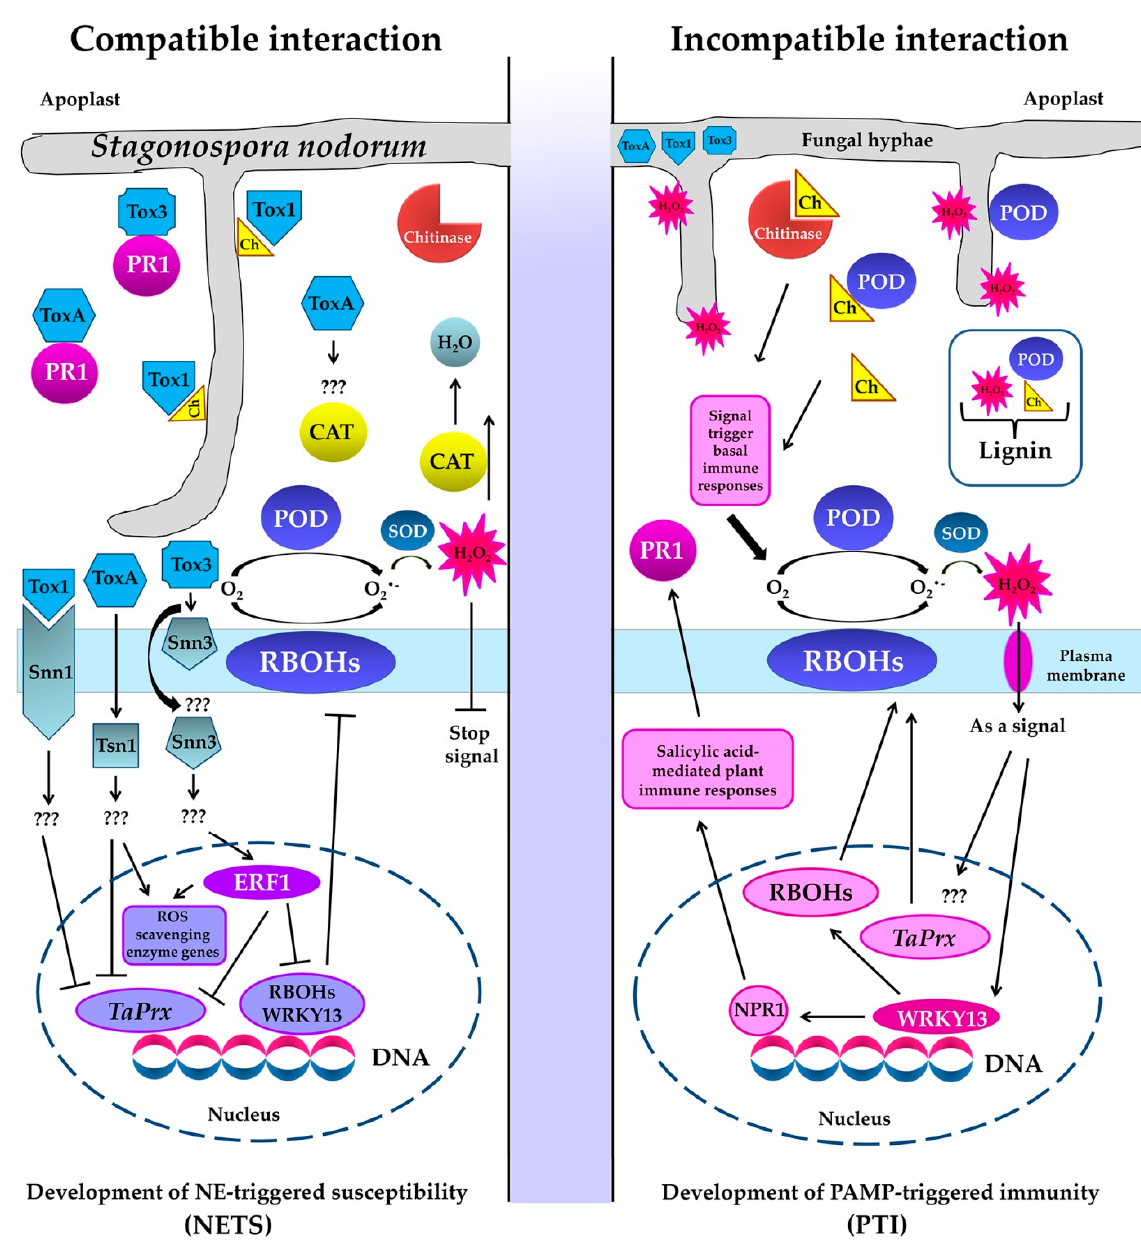
Figure 6. Model illustrating the development of necrotrophic effector-triggered susceptibility (NETS) in a compatible in- teraction and PAMP-triggered immunity (PTI) in an incompatible interaction with the participation of NEs SnToxA, SnTox1 and SnTox3 and enzymes of redox metabolism of the host plant (NADPH-oxidases localized on the plasmallema also known as respiratory burst oxidase homologs (RBOHs), peroxidases (POD) superoxide dismutase (SOD) and catalase (CAT)) in the S. nodorum – T. aestivum pathosystem. Legend: Ch—chitin, ERF1—transcription factor Ethylene responsive factor 1, NPR1—Nonexpressor of PR Genes1, TaPrx —gene encoding anionic peroxidase, —positive regulation, —negative regulation, ???—unknown signal transduction pathway.